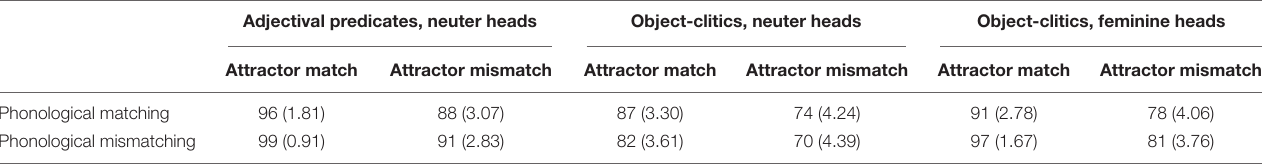
TABLE 7 | Participants’ mean accuracy and standard error in Experiment 3 grouped by Phonological